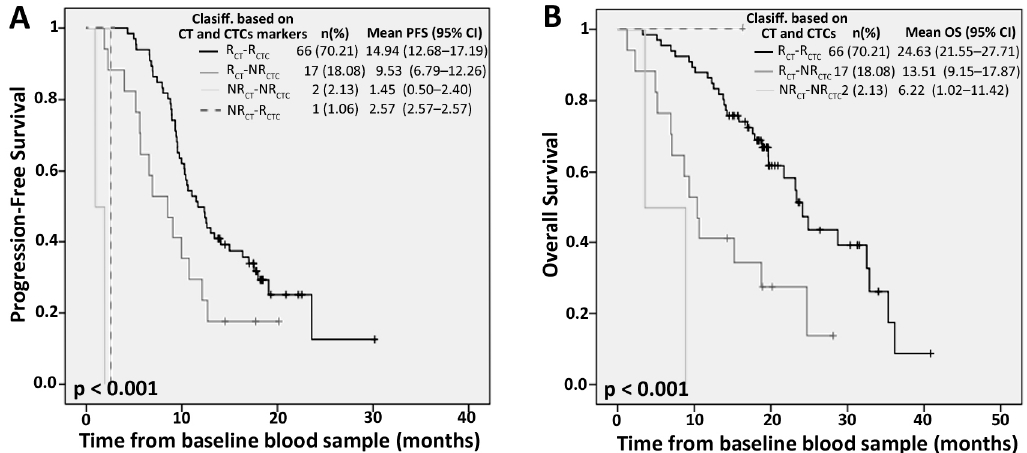
Figure 3. Kaplan-Meier curves showing progression-free survival (PFS) ( A ) and overall survival (OS) ( B ) according to the classification of a patient as responder (R) or non-responder (NR), based on the expression of the CTCs multimarker panel (CTC) and CT scan (CT).